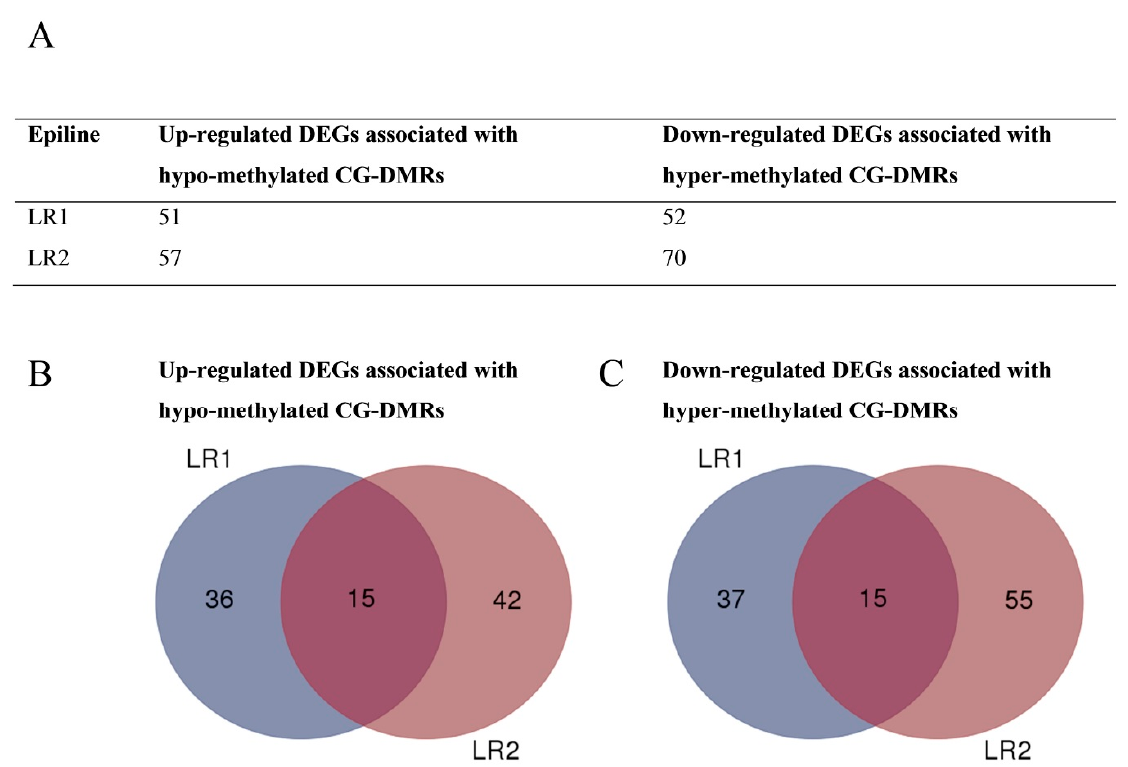
Figure 3. DEGs associated with upstream CG-DMRs in epilines compared with the control line. ( A ) Number of up-regulated DEGs associated with hypo-methylated CG-DMRs, and number of down-regulated DEGs associated with hyper-methylated CG-DMRs; ( B , C ) Comparison of up-regulated DEGs/hypo-methylated CG-DMRs ( B ) and of down-regulated DEGs/hyper-methylated CG-DMRs ( C ) between LR1 and LR2. The significant DMR ( q < 0.01, >25% methylation level difference) location needed to be located at less than 2 kb upstream of the gene transcription start site of the significantly DEG ( q < 0.05, no Log 2 FC threshold).